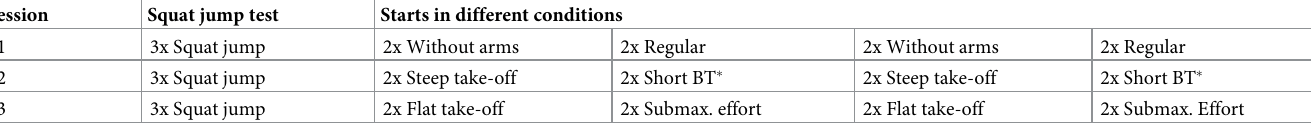
Table 2. Example of an individual protocol for the three test sessions (S1–S3Tables). Fig 1 provides a visual representation of all six conditions and a more elaborate explanation.